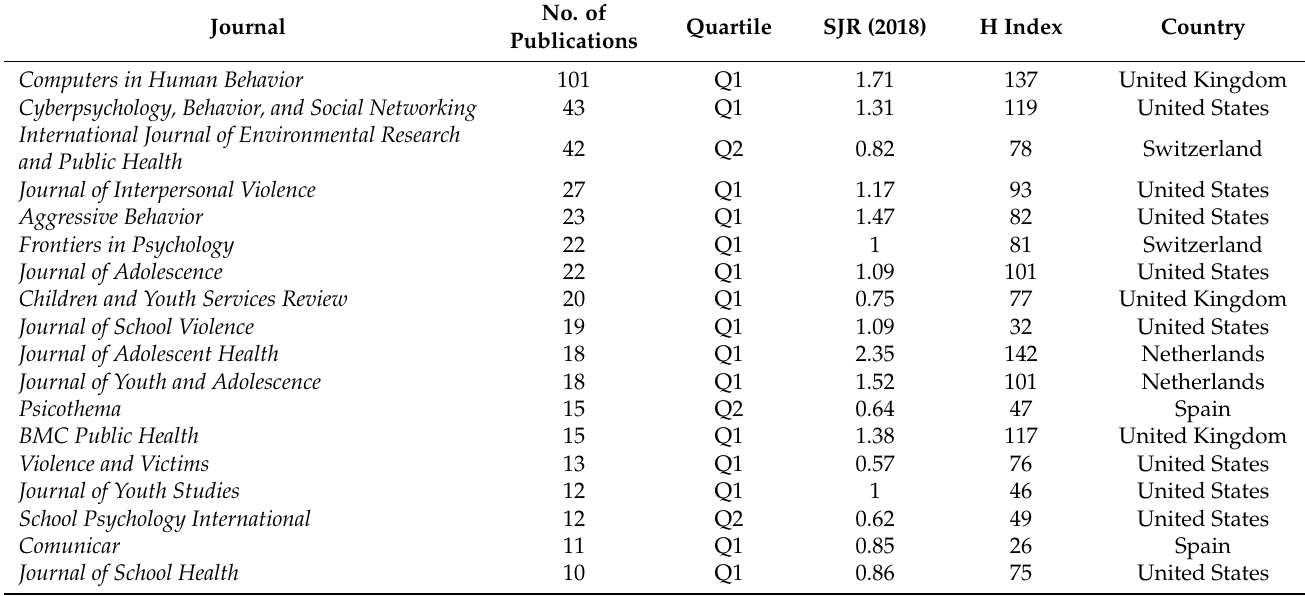
Table 1. Selection of journals with the most publications on adolescent cyberbullying.